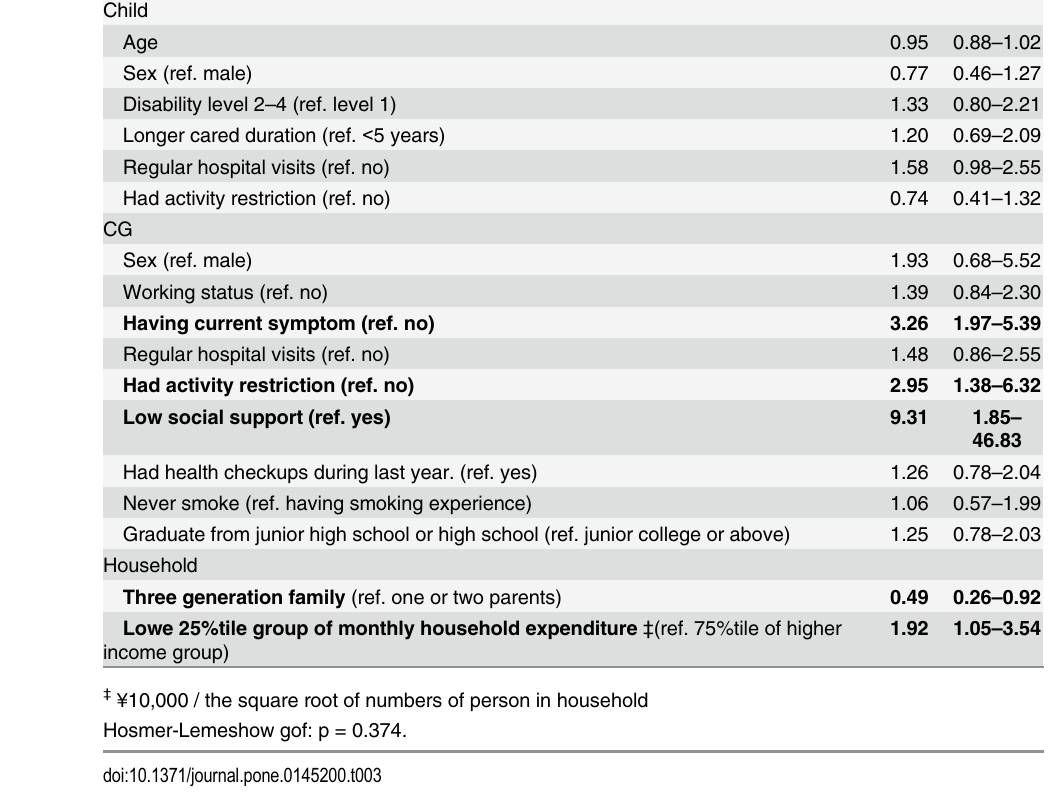
Table 3. Factors related to caregiver ’ s mental health (K6 ≧ 5) in multivariable logistic regression. (n =